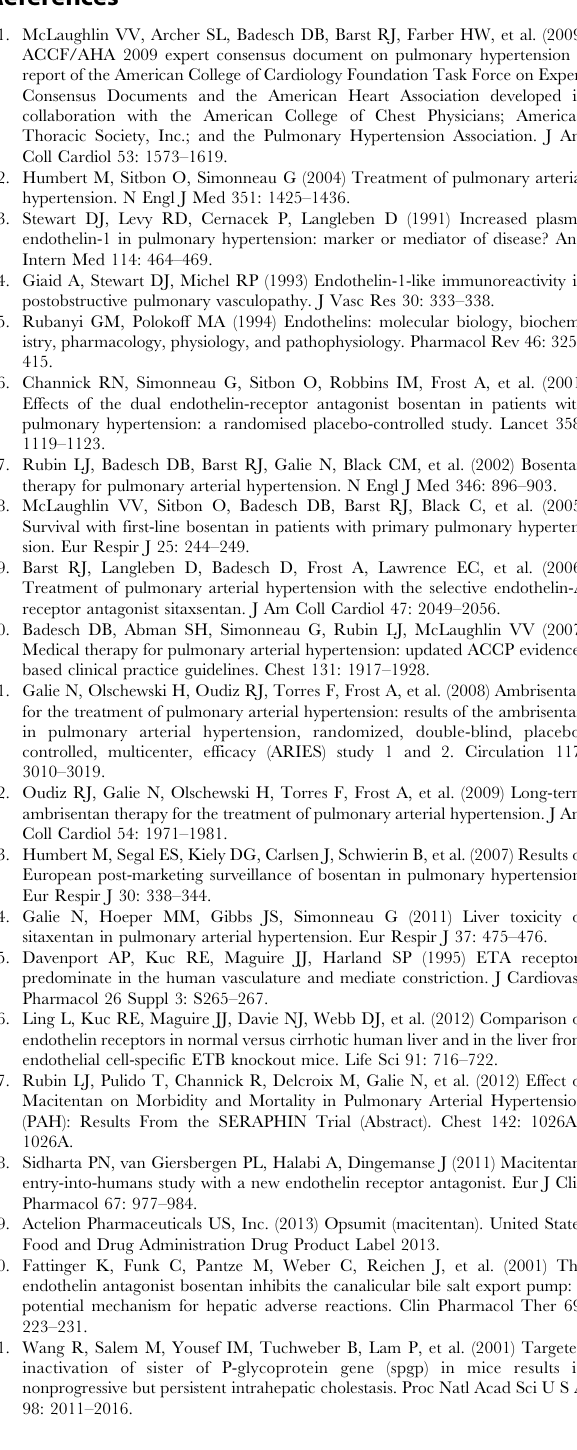
Table S3 The Effect of Ambrisentan, Bosentan, Maci- tentan and Sitaxsentan on the Distribution of Endoge- nous Glycochenodeoxycholic